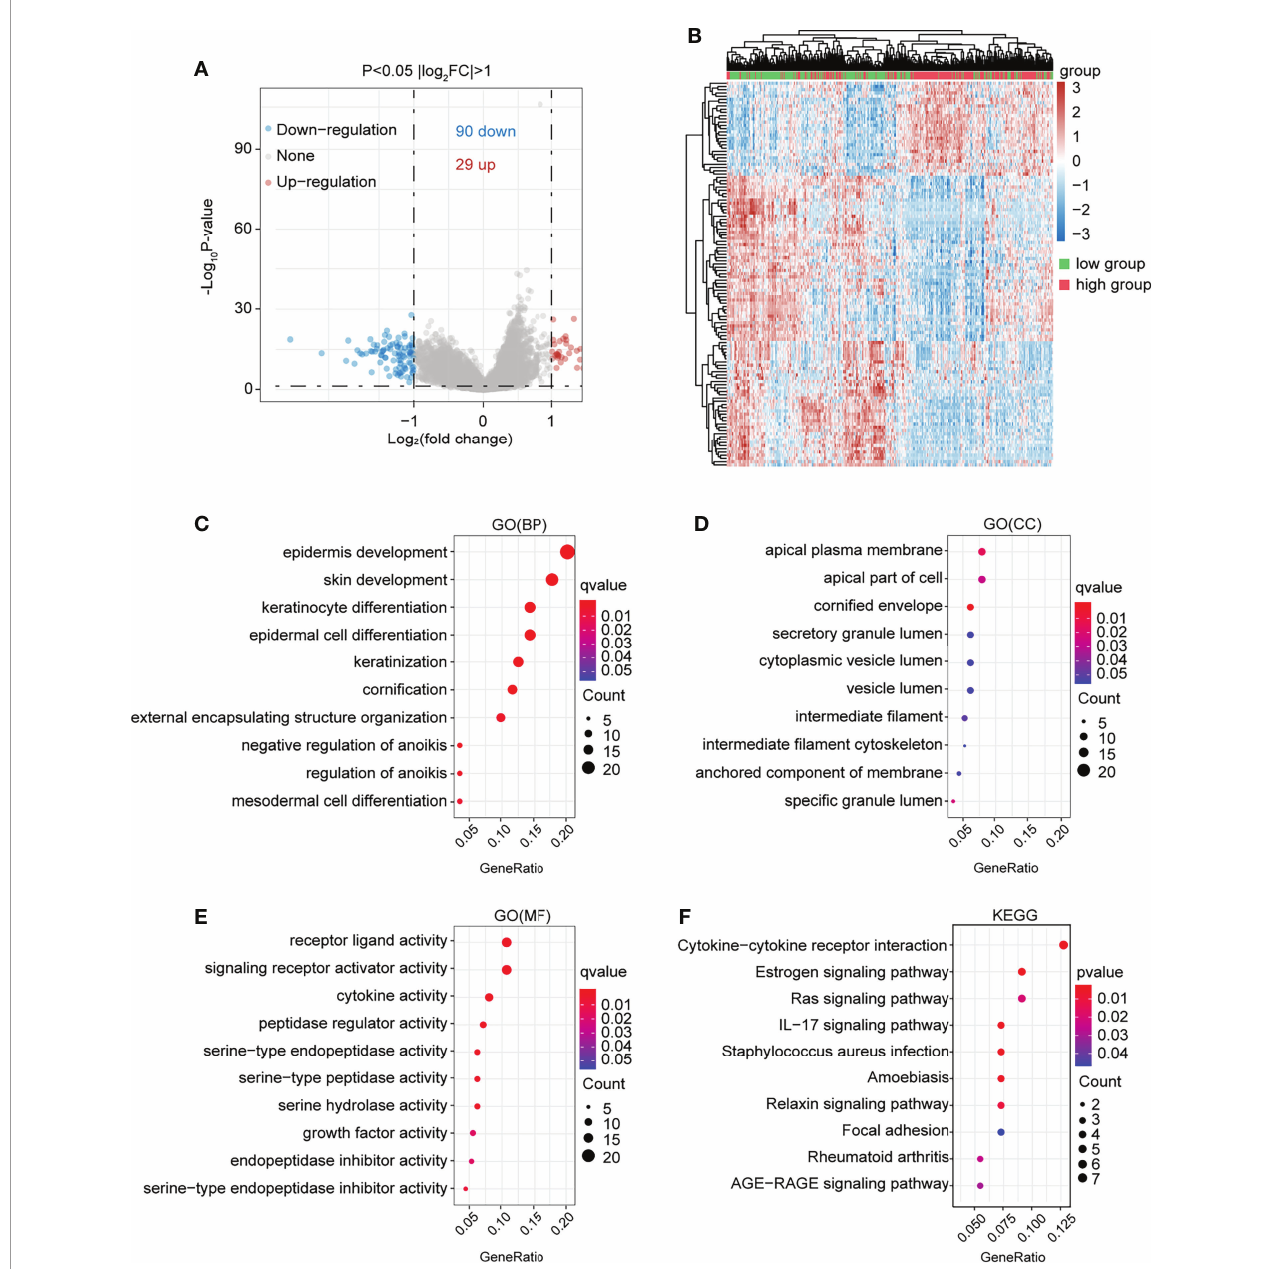
FIGURE 5 | Functional enrichment analysis of NTF2 related genes. (A) In the volcano map of HNSCC in TCGA database, red dots were up-regulated genes and blue dots were down-regulated genes. (B) Heatmap of differential genes between NTF2 high and low groups in TCGA database. (C – E) GO analyses. (F) KEGG